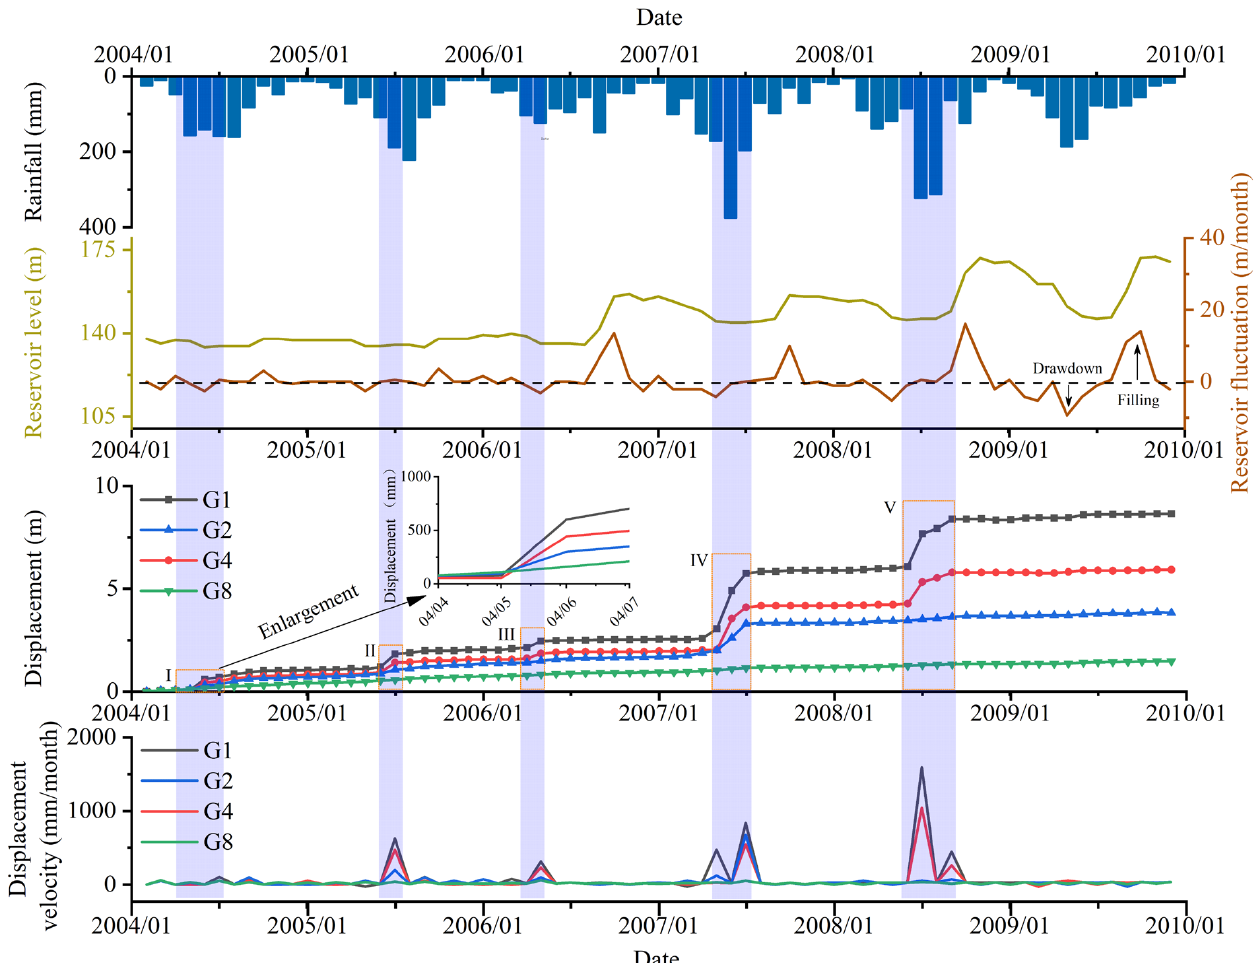
Figure 7. Displacement data from GPS points G1, G2, G4, G8, and rainfall and reservoir level data.